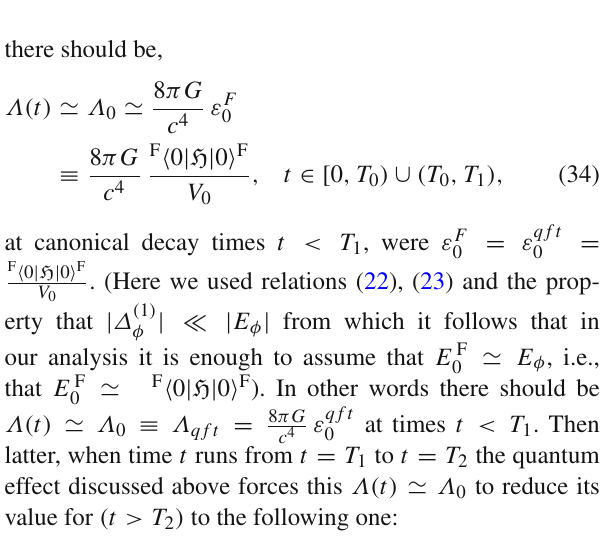
Fig. 5 An illustration of a behavior of energy E (τ) (or cosmological “constant” Λ( t ) ). Results obtained for ω BW ( E ) given by Eq. (28). The case β = 100. The solid line: κ(τ) = ( E (τ) − E min )/( E 0 − E min ) ≡ (Λ( t ) − Λ )/(Λ − Λ ) . The dashed line: E (τ) = E bare bare 0 or, Λ(τ) = Λ 0 = const, ( κ(τ) = 1). The time, t , is measured in